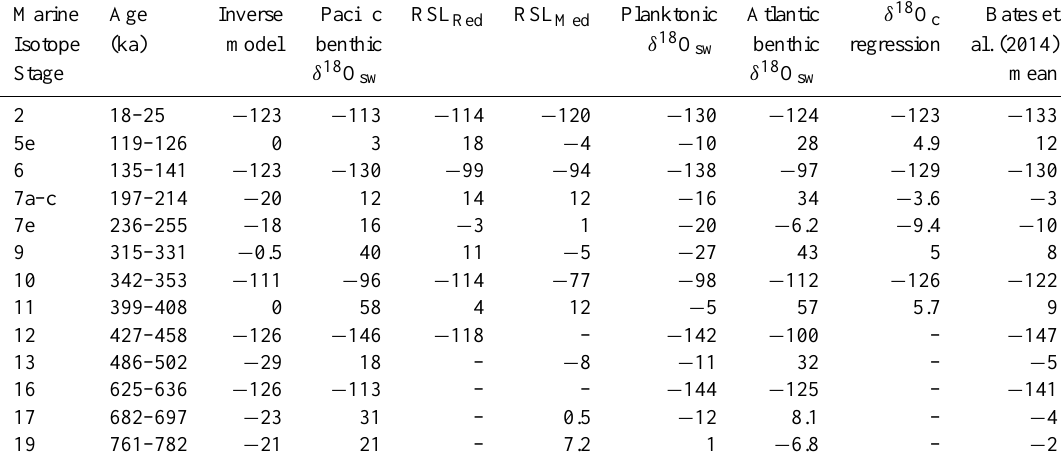
Table 2. Sea level highstand and lowstand estimates from individual records (in meters above modern). See Table 1 for references. The last column gives the mean values from nine cores in Bates et al. (2014); these estimates were not included in our PCA.